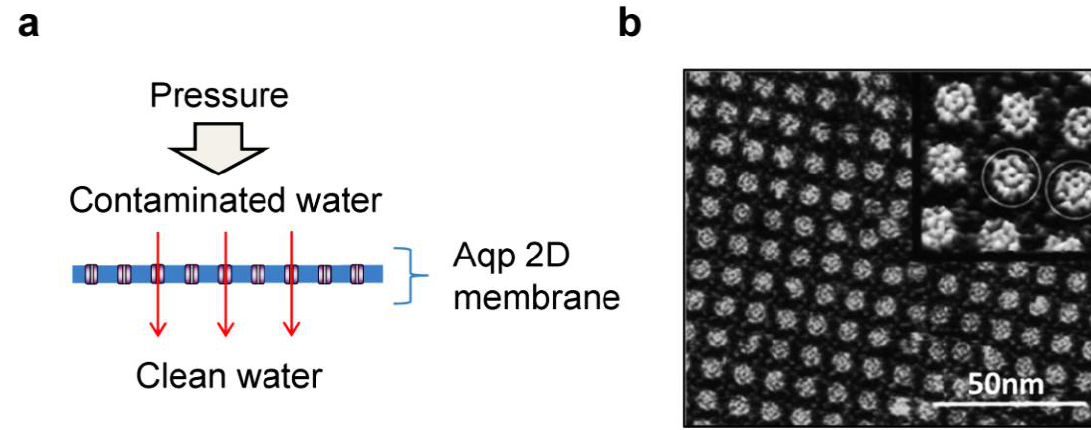
Figure 9. Reverse osmosis water purification membrane using aquaporin-incorporated planar membranes. (a) Schematic diagram of the reverse osmosis water purification membrane made with aquaporin-embedded 2-dimensional planar membrane; (b) AFM topography of AqpZ crystal (adapted with permission from [101]. Copyright 1999 Macmillan Publishers